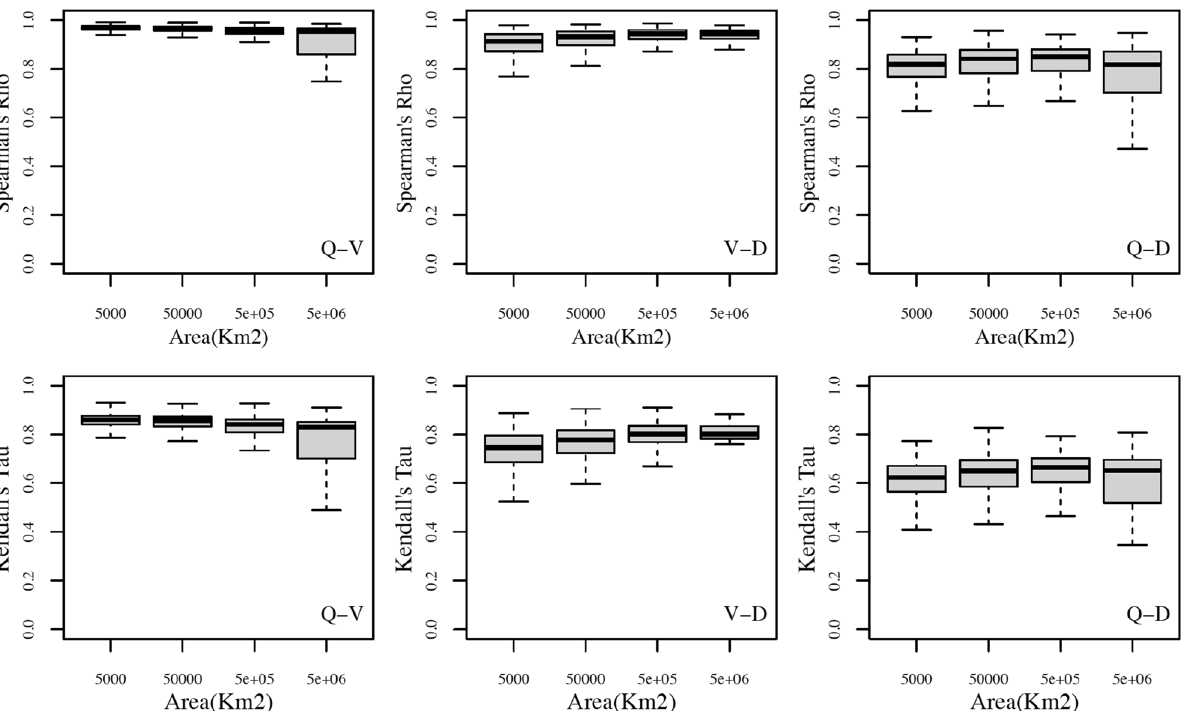
Figure 1. Boxplots of the measures of dependence (Spearman’s rho in upper panels and Kendall’s tau in lower panels) as function of the catchment area, for each couple of flood variables (Q–V in the left column, Q–D in the right column, V–D in the intermediate column), using stations with at least 40 events and the 90th percentile of daily discharge as threshold. The catchment area is divided in four classes: small (500, 5000] km 2 , medium